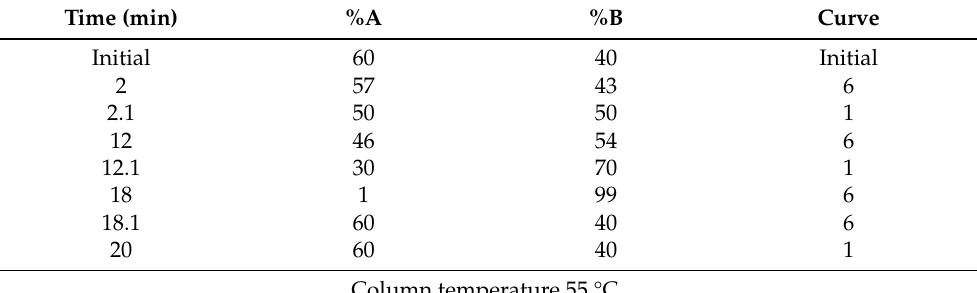
Table 2. Chromatography